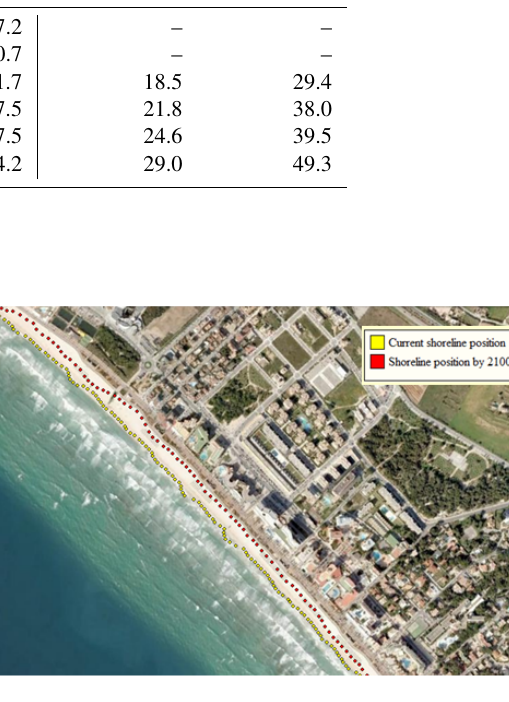
Figure 18. Present-day shoreline position (in black) and landward migration (in red) in the worst case scenario (mean sea level rise under RCP85 and extreme wave conditions) by the end of the 21st century in Playa de